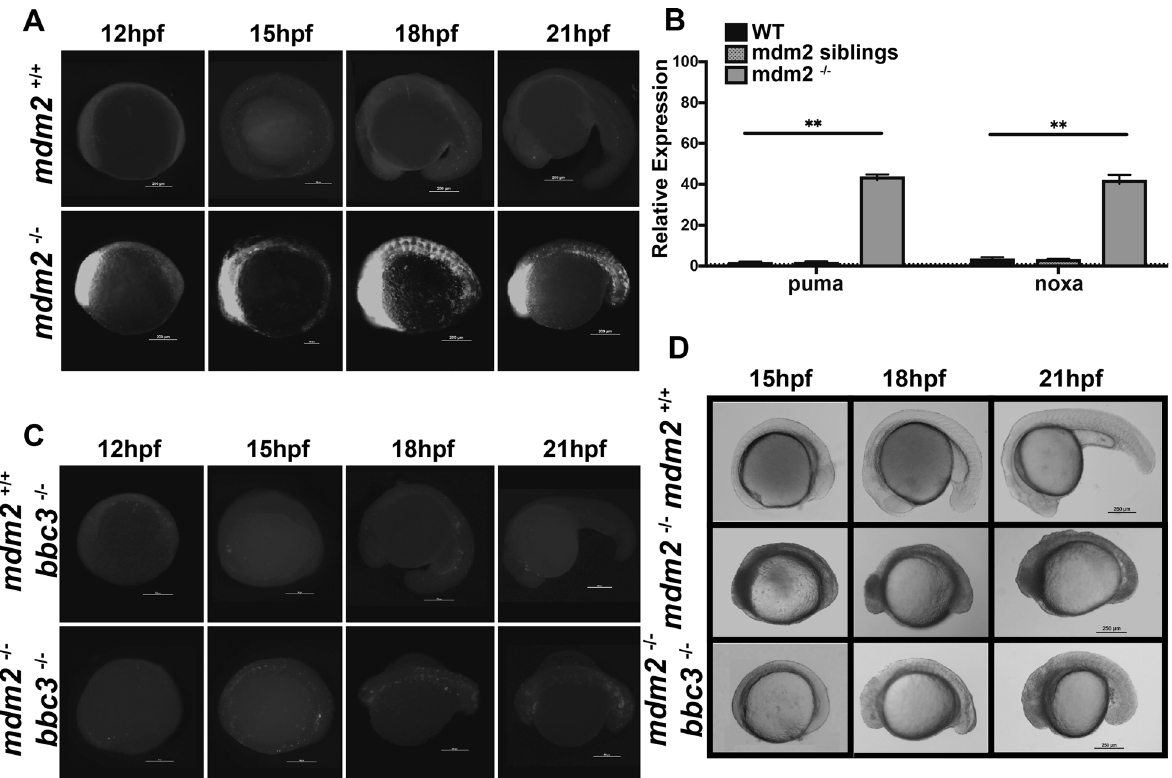
Fig. 4 Loss of puma rescues mdm2-null induced apoptosis at early embryonic stage. A Anti-active Caspase-3 staining on 12, 15, 18, and 21 hpf mdm2 + / + and mdm2 − / − zebra fi sh embryos. B qRT-PCR analysis of puma and noxa in 15 hpf mdm2 + / + , mdm2 siblings (mdm2 + / + and mdm2 + / − ) and mdm2 − / − zebra fi sh embryos. n = 3 from ~30 pooled embryos per sample. Bars represent mean ± SEM. ** p < 0.01. C Anti-active Caspase-3 staining on 12, 15, 18, and 21 hpf mdm2 + / + bbc3 − / − and mdm2 − / − bbc3 − / − zebra fi sh embryos. D Gross images of 15, 18, and 21 hpf mdm2 + / + , mdm2 − / − , and mdm2 − / − bbc3 − / − zebra fi sh